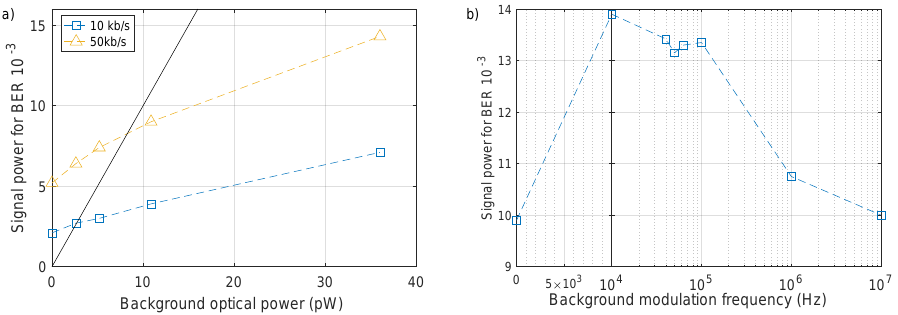
Figure 5. ( a ) Required signal power to attain a BER of 10 − 3 under constant background power for 50 and 10 kb/s. Equal signal and background power is indicated by the solid line. ( b ) Required signal power to attain a BER of 10 − 3 under modulated background conditions. Required power increases by approximately 40% when background modulation rates are comparable to the signal data